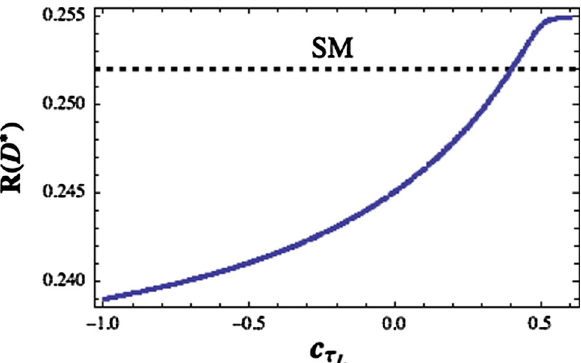
Fig. 10 R ( D ∗ ) in custodial RS models as a function of c τ line represents the SM